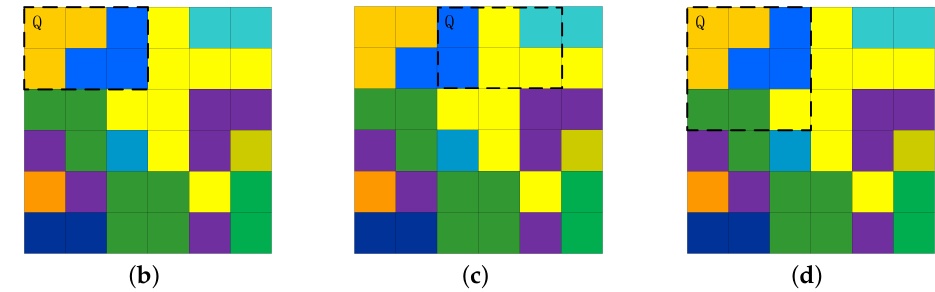
Figure 10. Three use cases of the querying range Q. ( a ) Use case (1); ( b ) Use case (2); ( c ) Use case (3); ( d ) Use case